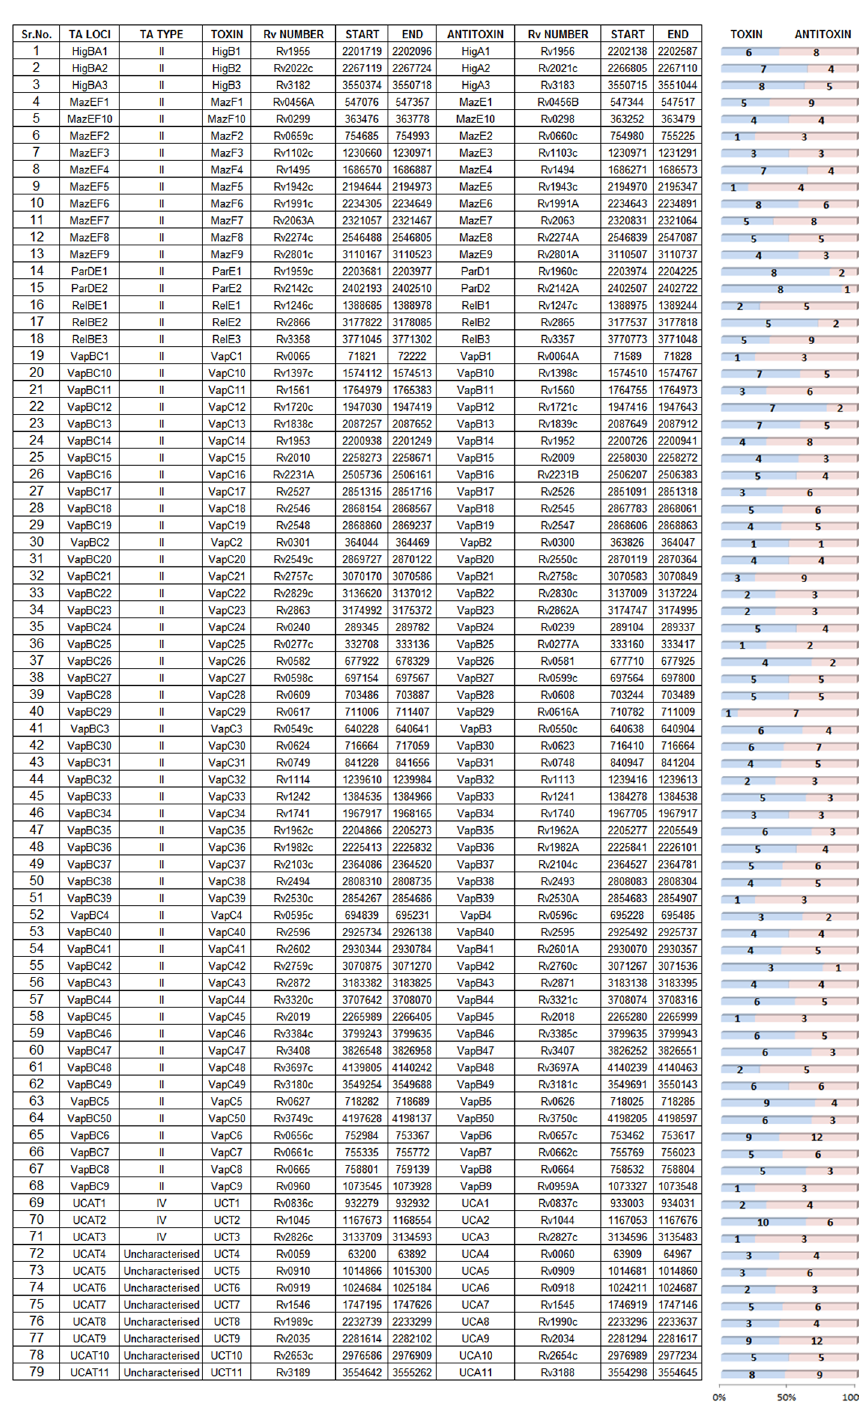
Figure 1. Toxin Antitoxin loci encoded by Mycobacterium tuberculosis H37Rv The 79 TA loci present in M. tuberculosis H37Rv genome tabulated with the locus name, gene name for toxin and antitoxin, gene identifier (Rv number), genomic location as Start base position and End base position, orientation in the genome and the type of TA locus. The uncharacterized TA loci are given the nomenclature as ucAT followed by a number for the series. The number in the blue bar indicates the total number of experimental conditions wherein differential expression was observed for the toxin gene and the number in the pink bar indicates the same for the antitoxin